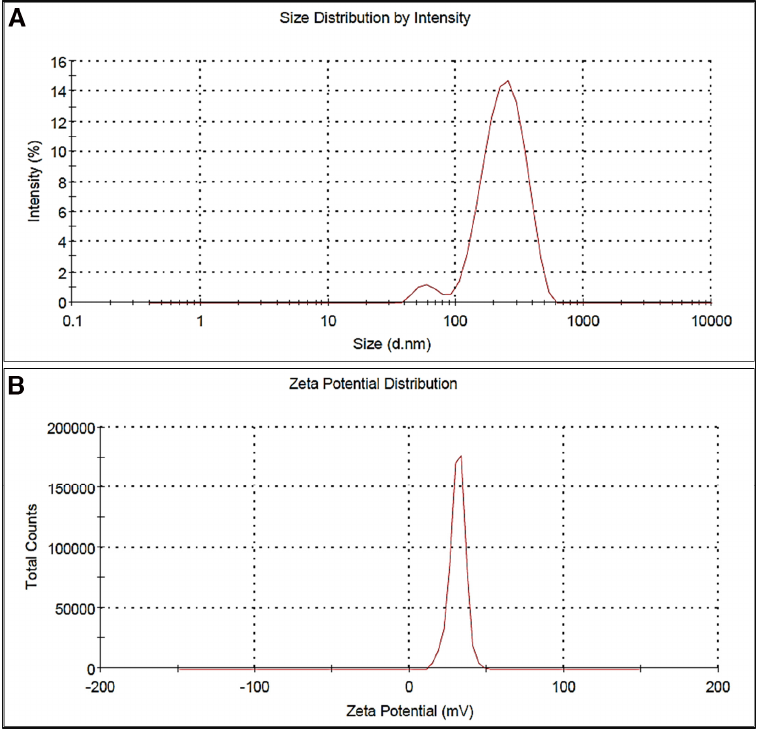
Figure 1. DLS analyses of ZnO NPs ( A ) and zeta potential ( B ).